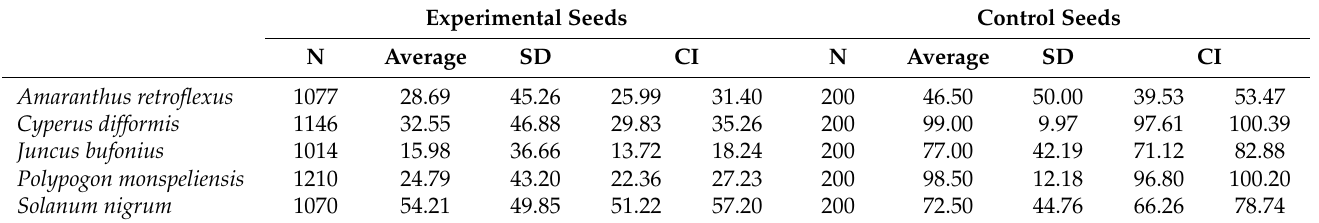
larger seeds (Figures 1 and 2, Pearson’s correlation between germination ratio between